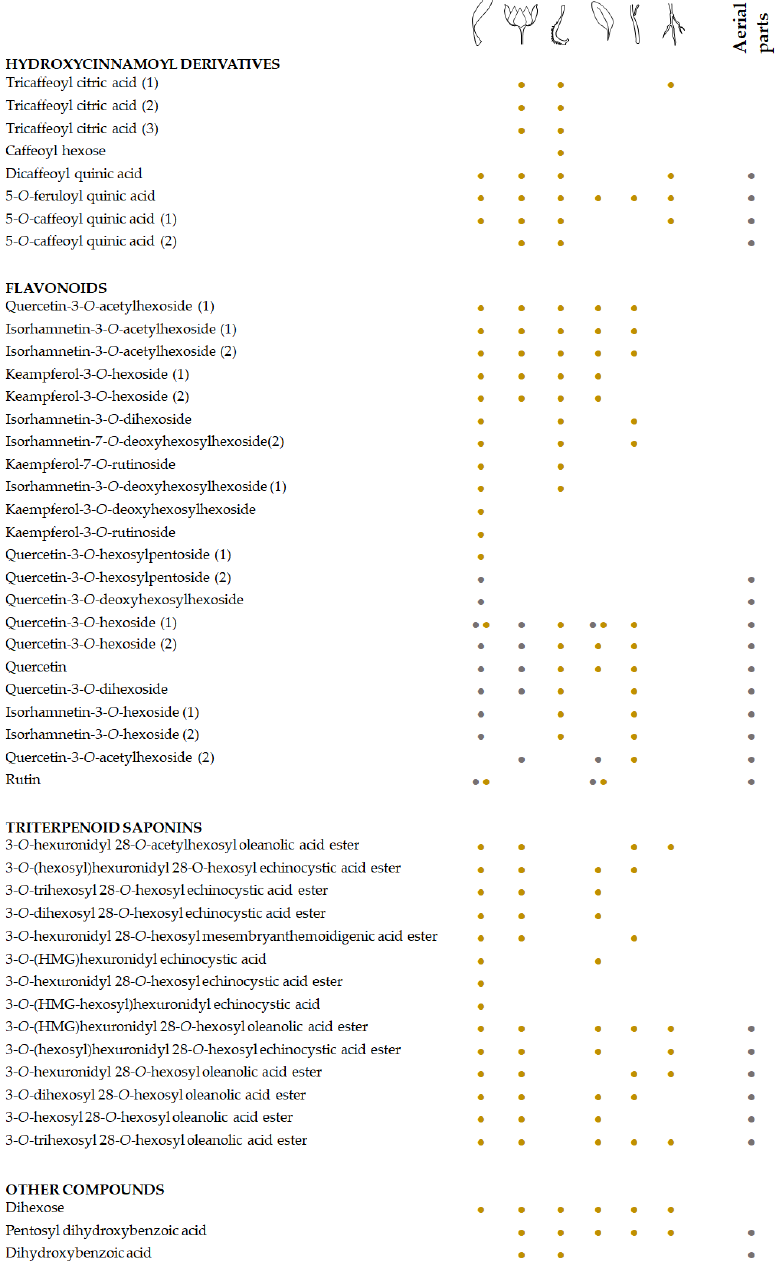
Figure 6. Comparison of the specialized metabolites herein identified in the different organs from Calendula arvensis (•) and in previous literature reports (•) [38,39,57,65,77]. The diversity in flavonol glycosides has not been highlighted before in the few studies conducted, relating to the phytochemical aspects of the species (Figure 6). In this context, an in ‐ depth study of the current literature highlights that a large portion of the compounds identified have not been reported before as constituents of C. arvensis , where several studies underline their presence in other species of the same genus, even if different from the more attentive C. officinalis . However, recently, some beneficial